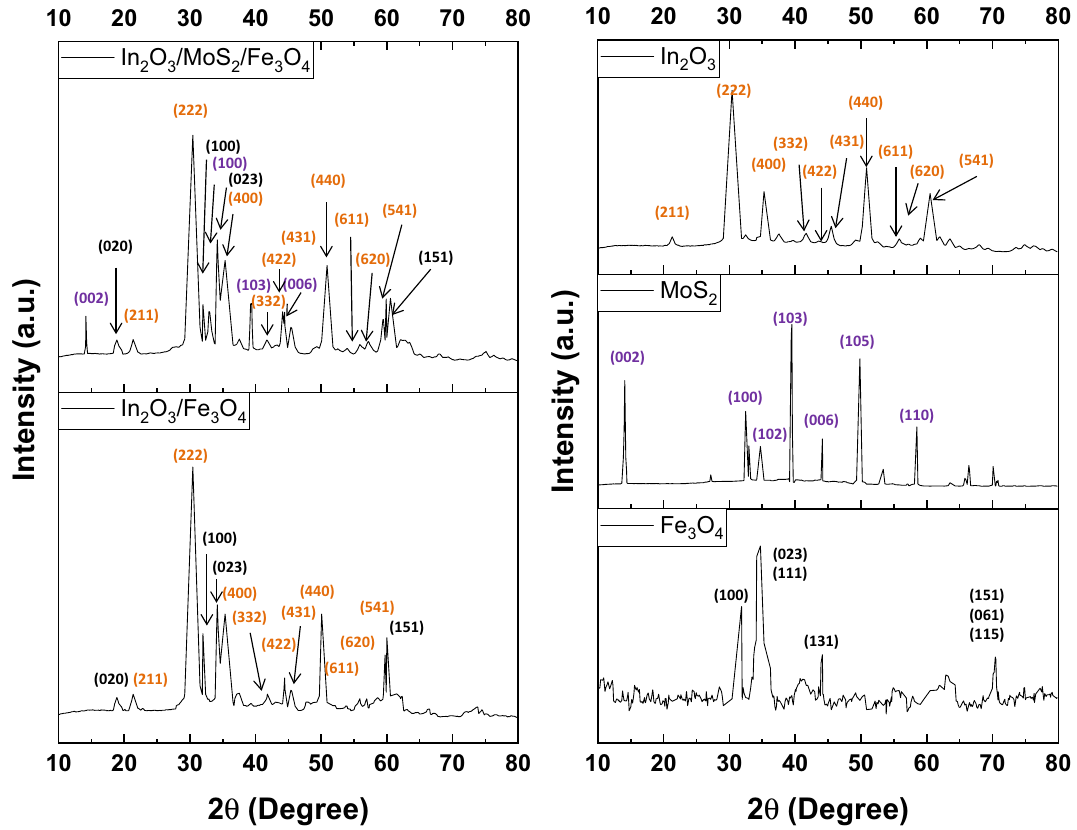
Figure 1. XRD patterns of different samples of In 2 O 3 /MoS 2 /Fe 3 O 4 , In 2 O 3 /Fe 3 O 4 , In 2 O 3 , MoS 2 and Fe 3 O 4